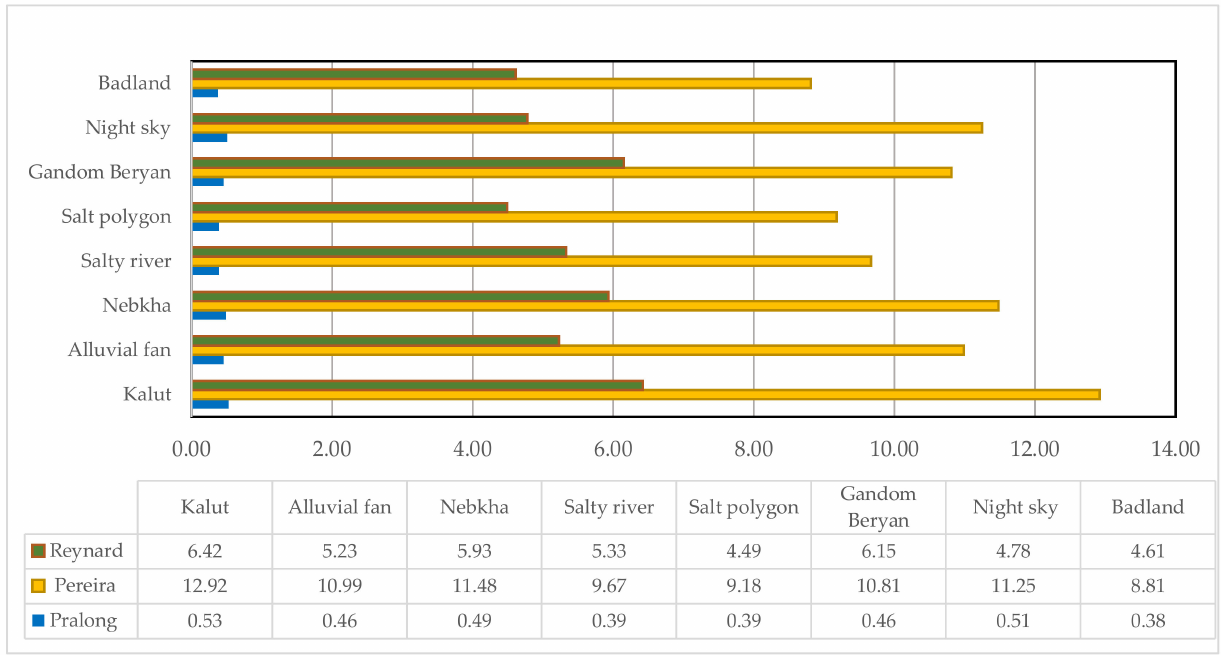
Figure 5. The results of the three